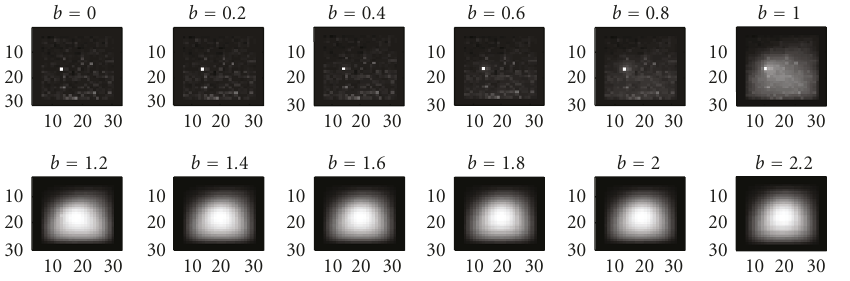
Figure 12: Last processed frame (25th) for b = [0 ··· 1].